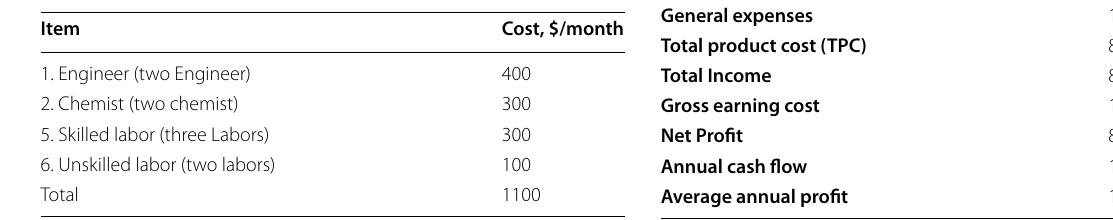
Table 6 Monthly plant labor Costs (OPC) as the Egyptian worker salaries in government